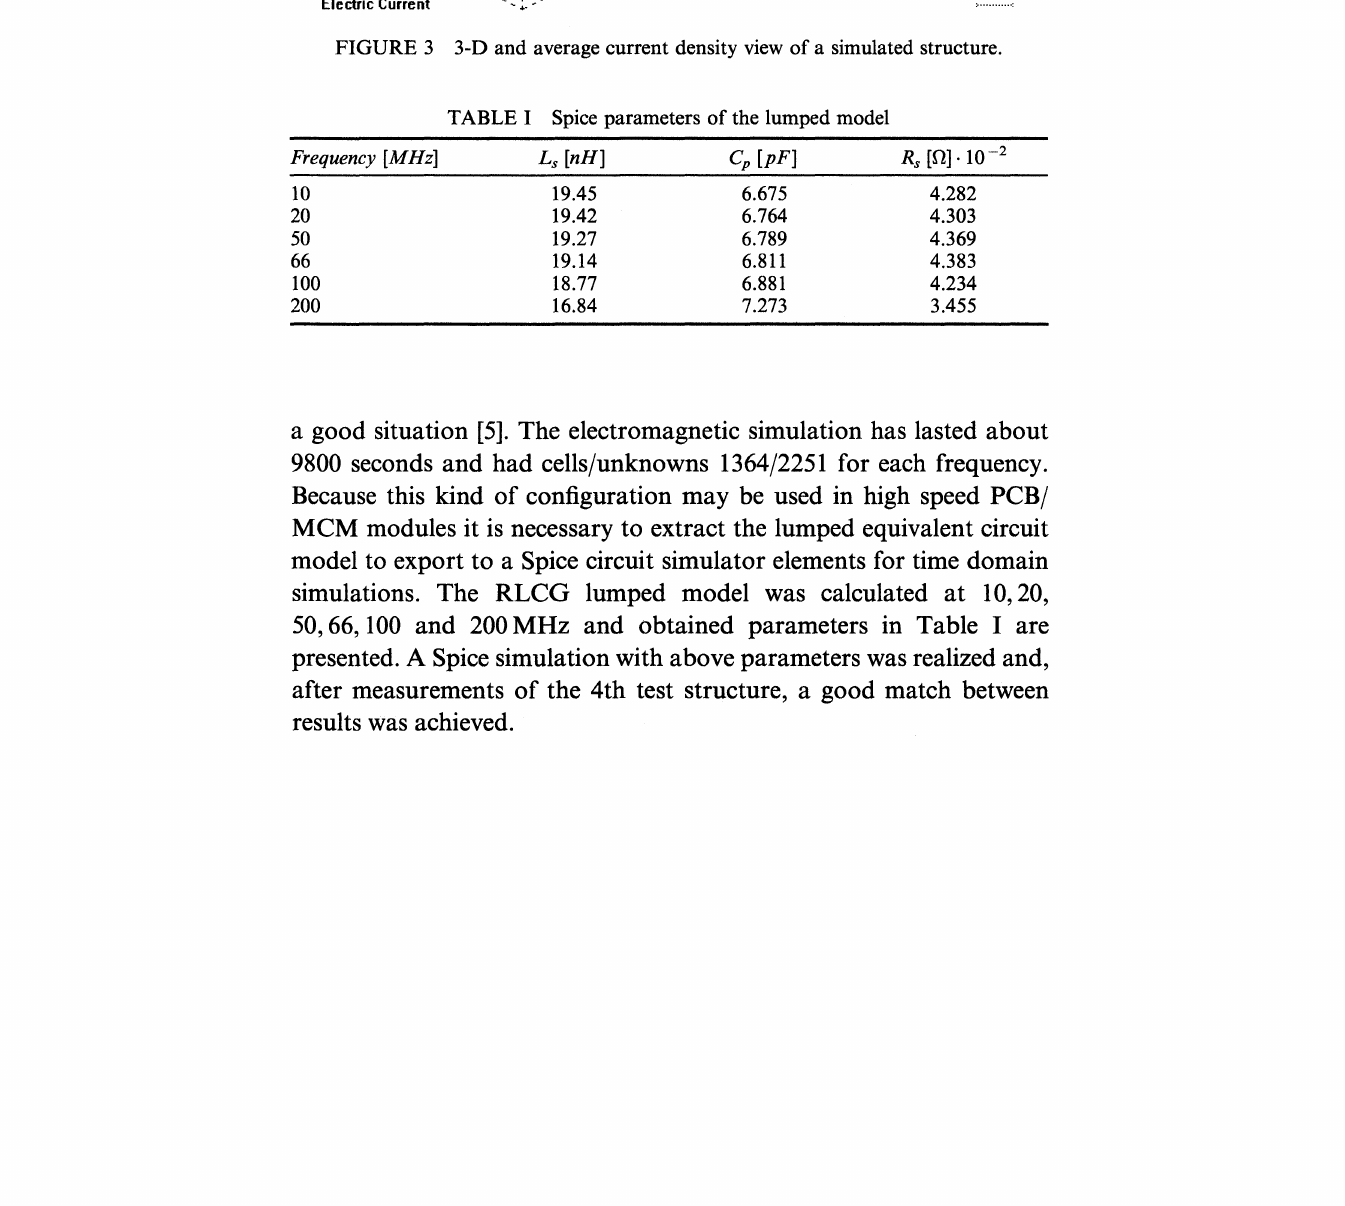
FIGURE 3 3-D and average current density view of a simulated structure. Spice parameters of the lumped